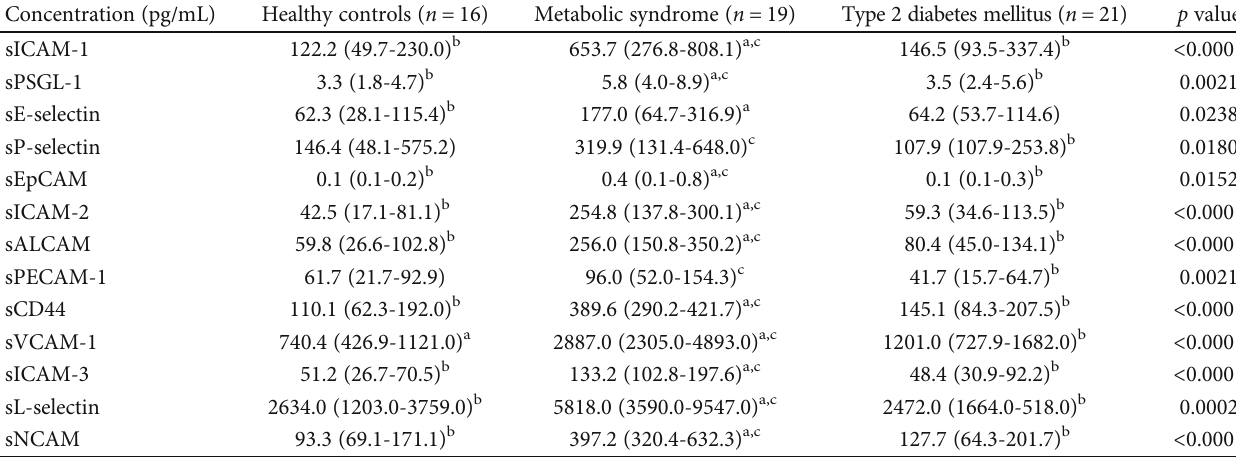
Table 3: Adhesion molecule pro fi le in children and adolescents with type 2 diabetes mellitus, metabolic syndrome, and healthy controls. Concentration (pg/mL)